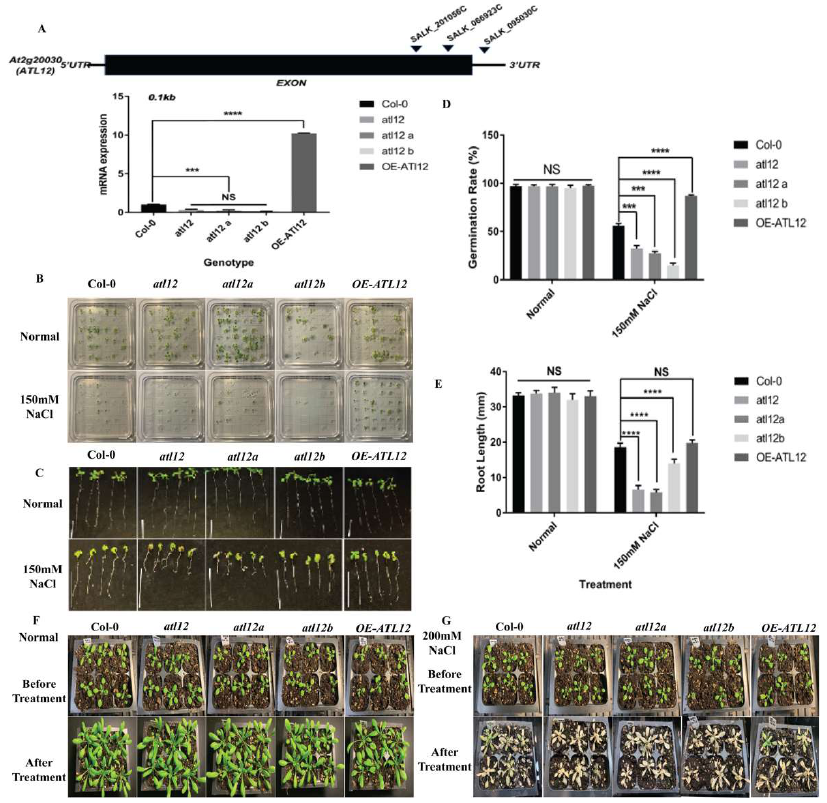
Figure 2. Phenotypic analysis of ATL12 in response to salt stress. ( A ) Analyses of T-DNA mutants in the AT2G20030 gene. The locations of the T-DNA insertions in the AT2G20030 gene, SALK_066923C, SALK_095030C , and SALK_201056C , are shown by arrowheads. qRT-PCR analysis of ATL12 transcript expression in the atl12 mutant, Col-0 wild type, and ATL12 over-expression line. Error bars indicate mean ± SD of three independent experiments; ( B ) Images of Col-0 wild type, atl12 mutants, and overexpression line germinated in normal and 150 mM NaCl contained MS agar plates. ( C ) Images of Col-0 wild type, atl12 mutants, and overexpression line root length growth. ( D ) Germination rate analysis of Col-0 wild type, T-DNA insertional mutants of atl12 , atl12a , and atl12b , and the overexpression (OE) line of ATL12 in response to salt stress. Error bars indicate mean ± SD of five independent experiments. ( E ) Primary root length growth analysis of Col-0 wild type, T- DNA insertional mutants of atl12 , atl12a , and atl12b , and the overexpression (OE) line of ATL12 in response to salt stress. ( F , G ) Salt tolerance of Col-0 wild type, atl12 mutants, and overexpression line under normal condition and salt condition. NS: no significance; *** indicated p < 0.001, **** indicated p < 0.0001. 2.2. Expression Pattern of ATL12 under High Salt Conditions To analyze the expression pattern of ATL12 at the tissue level, we fused the promoter of ATL12 with the GUS reporter gene and generated transgenic plants. As shown in Figure 3A, ATL12 is expressed in the root, stem, and leaves of two-week-old seedlings, and in mature flowers. To confirm the tissue-specific expression, the expression levels of ATL12 were tested using RT-PCR in the root, leaf, and stem of two-week-old seedlings, in mature flowers, and in dried seeds of Col-0 wild-type plants. As shown in Figure 3B, the ATL12 transcript was detected in the root, stem, and flower, but its expression was relatively low in the leaf tissue.